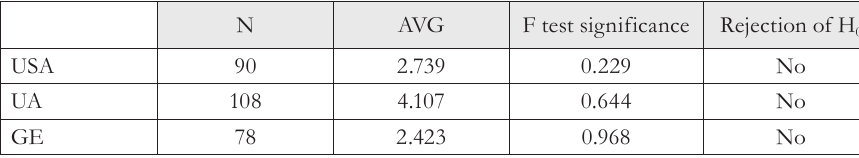
Tab. 8 - Hard sell vs. soft sell – attitude towards unknown brand (Ab). Source: authors’ re- search.